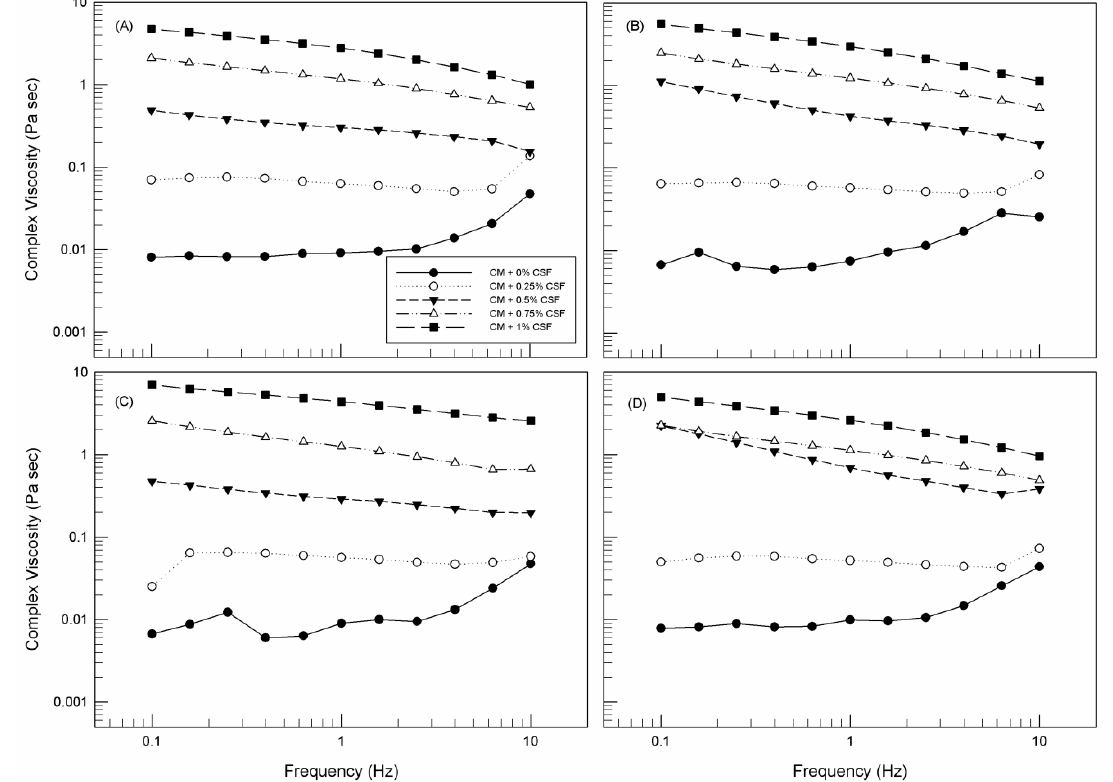
Figure 4. Complex viscosity (Pa·sec) versus frequency (Hz) for yogurt-like structures made of coconut milk and increasing concentration of carob seed flour. The samples were analyzed at time 0 ( A ), 24 h ( B ), 48 h ( C ) and 5 ( D ) days of storage. The illustrated results were representative of three independent experiments.